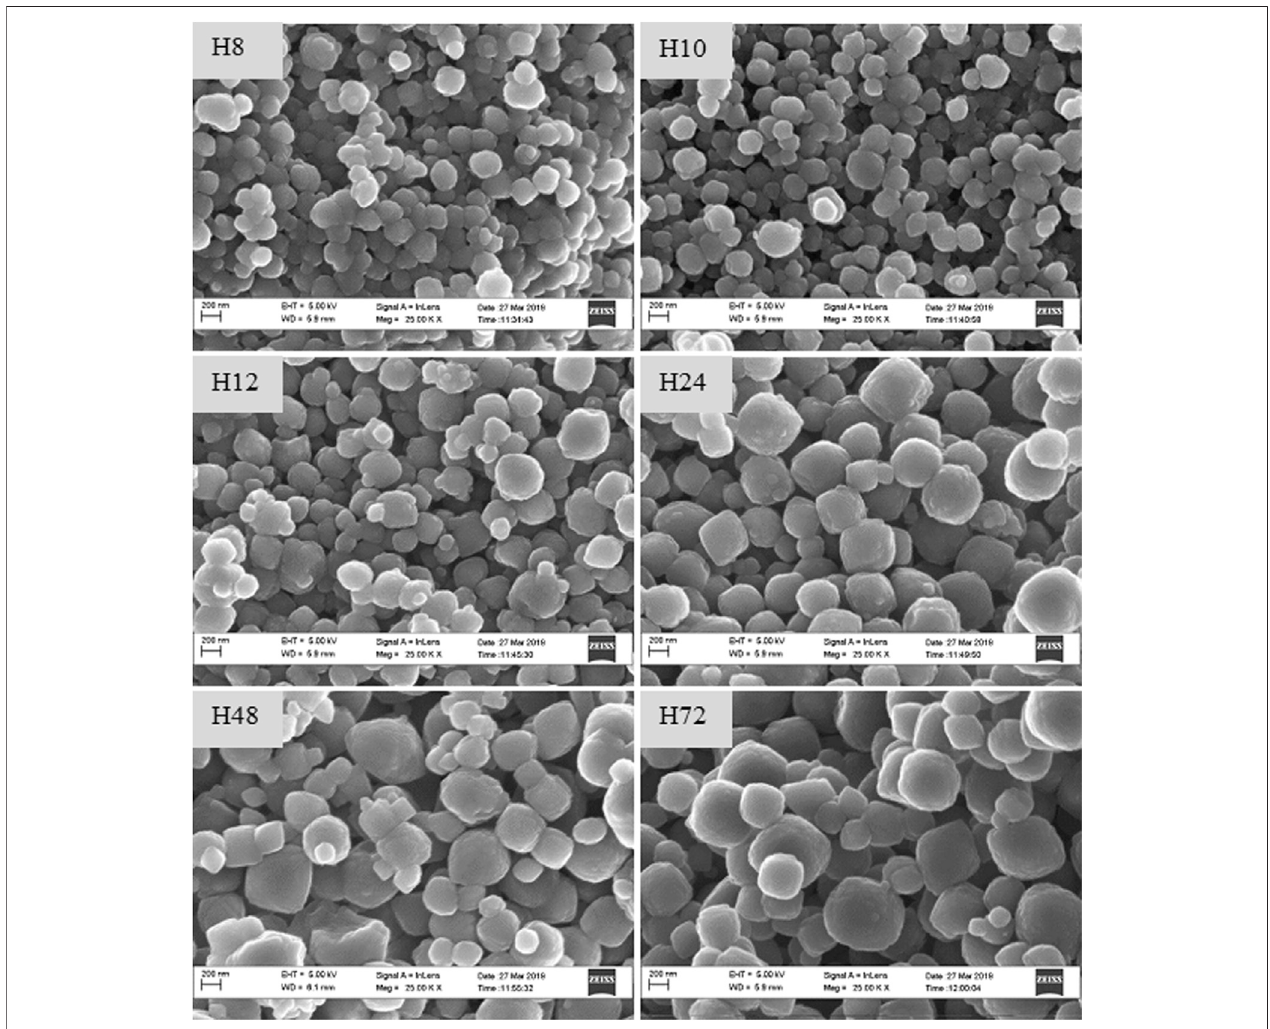
FIGURE 4 | SEM images of as-synthesized HBEA zeolites produced from CFA nanosilica extract at different water contents and hydrothermal times.